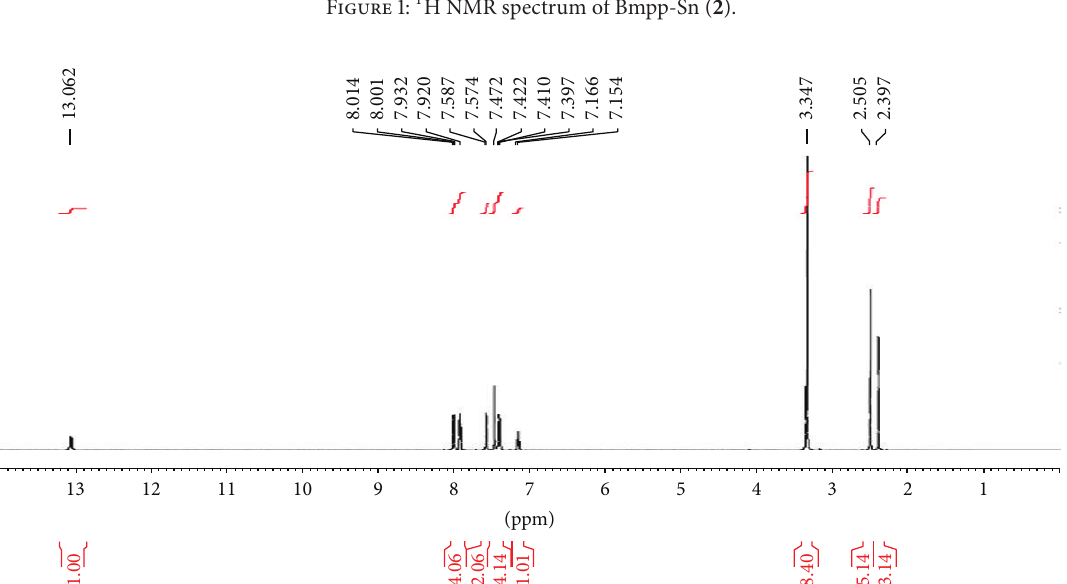
Figure 2: 1 H NMR spectrum of Ampp-Sn ( 1